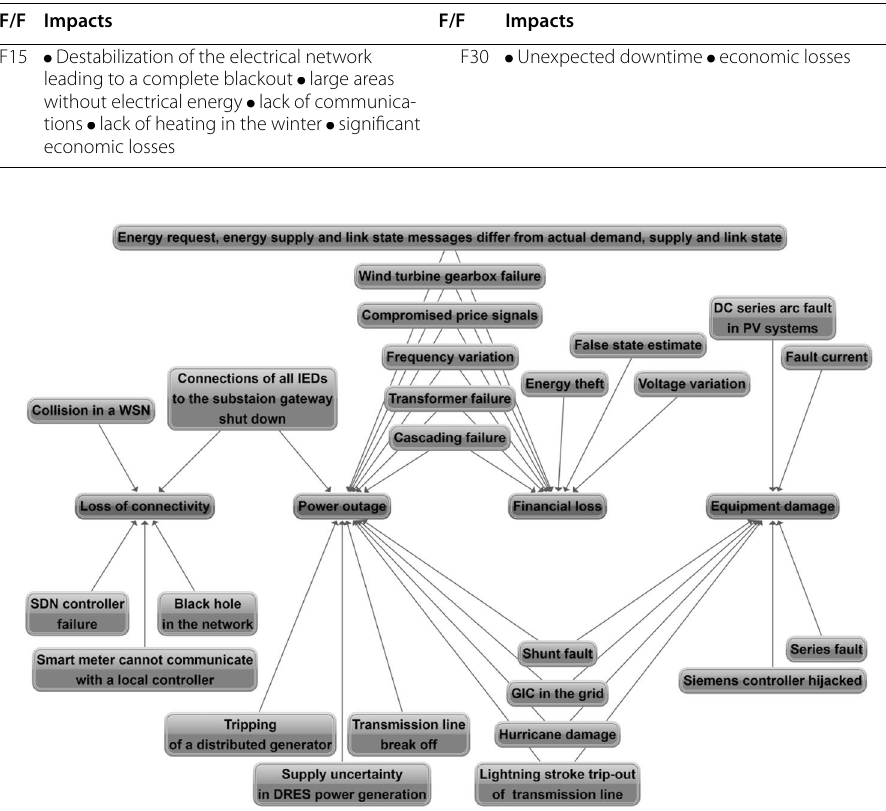
Fig. 4 RQ4. Most common consequences and their